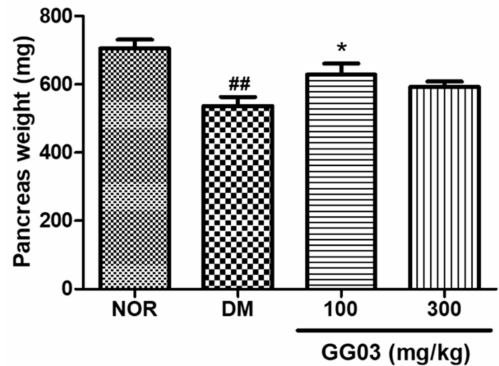
Figure 9. Pancreas weight at week 18 ( ## p < 0.01; compared to NOR), (* p < 0.05; compared to DM). NOR =